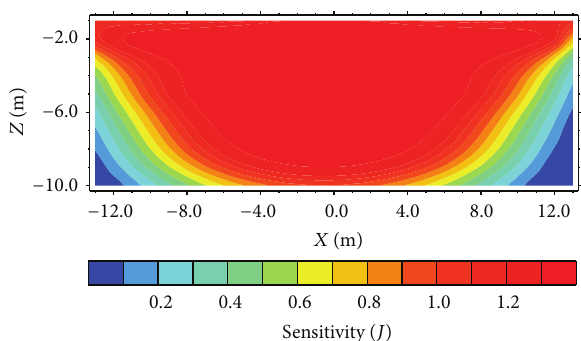
Figure 3: Modified sensitivity distribution in 𝑋𝑍